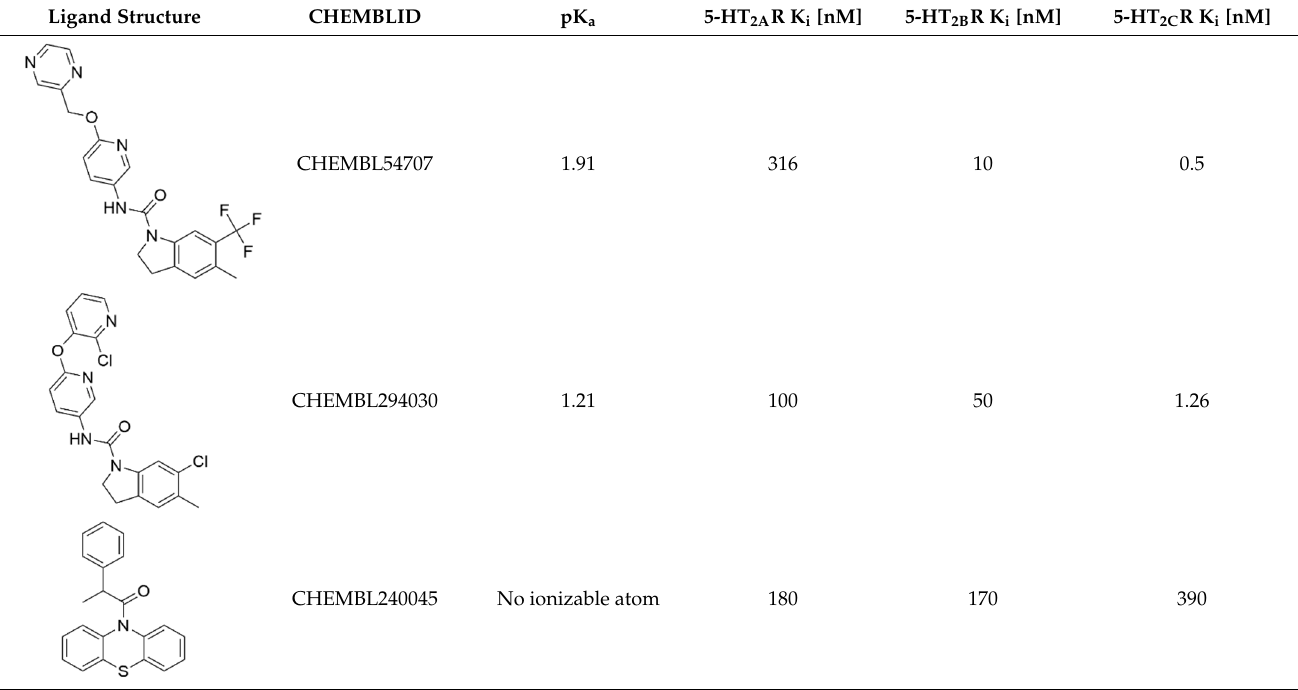
Figure 2. Venn diagram of non-basic ligands of 5-HT 1B , 5-HT 2A , 5-HT 2B , and 5-HT 2C receptors. Table 3. Examples of nonbasic ligands displaying simultaneous activity towards 5-HT 2A , 5-HT 2B , and 5-HT 2C receptors, together with their affinities expressed as K i .